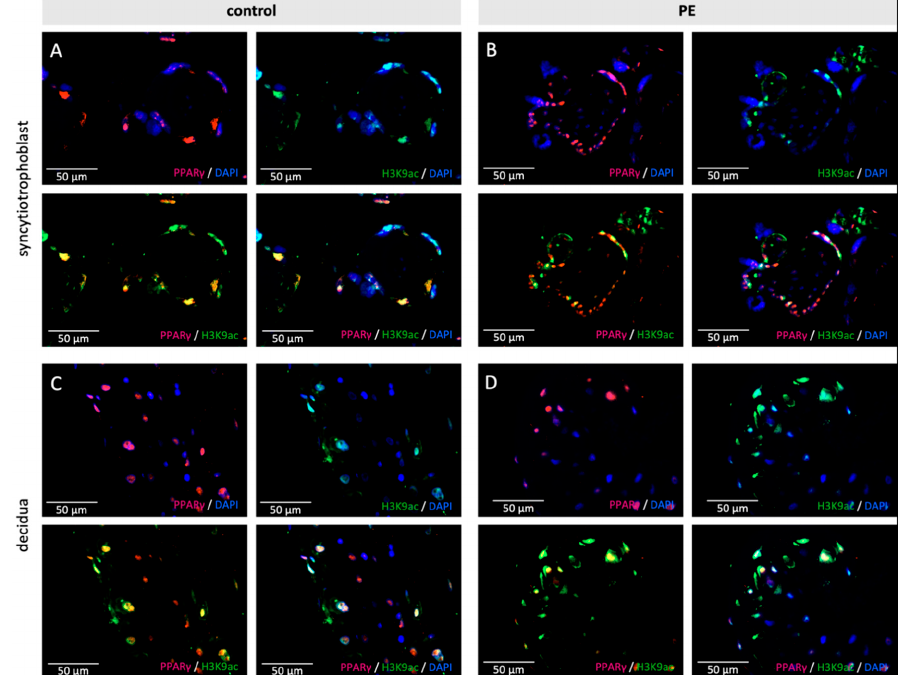
Figure 4. Examples of staining results of the immunofluorescence of PPAR γ and H3K9ac ( A , B )/H3K4me3 ( C , D ), in control and PE placentas. Single immunofluorescence staining of H3K9ac and H3K4me3 (pink). Single immunofluorescence staining of PPAR γ (green). Double immunofluorescence staining of H3K9ac ( A / B ) and H3K4me3 ( C / D ) (red) and PPAR γ (green). DAPI as nucleus staining (blue). Scale bar 100 µ m. Int. J. Mol. Sci. 2021 , 22 , 12469